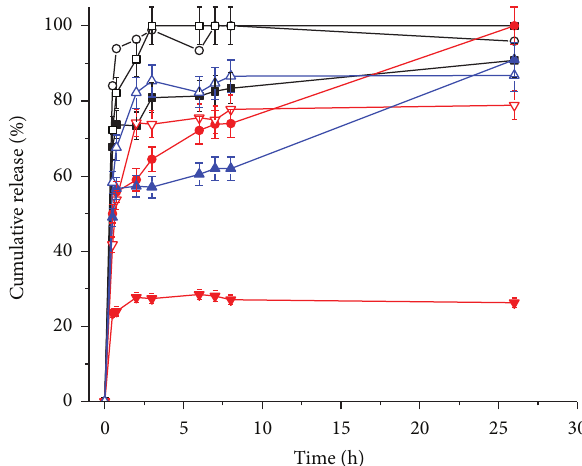
Figure 8: Release of 5-fluorouracil from star polymer } in PBS { [poly(NIPAAm- 𝑐𝑜 -4MBA)- 𝑏 -polyHA] 1 -EGDMA 10 at pH 7.4 ( ◼ ) and PBS at pH 6 ( ◻ ) and from star polymer [polyNIPAAm- b -polyHA] 1 -EGDMA 10 in PBS at pH 7.4 ( I ) with temperature jump cycles from 37 to 42 ∘